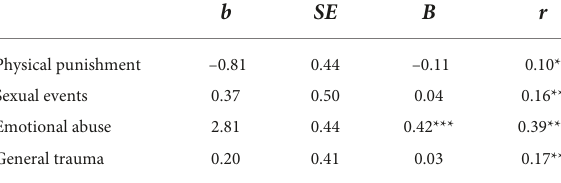
TABLE 2 Linear regression coefficients predicting loneliness from early life experiences of trauma assessed using the ELTI in Study